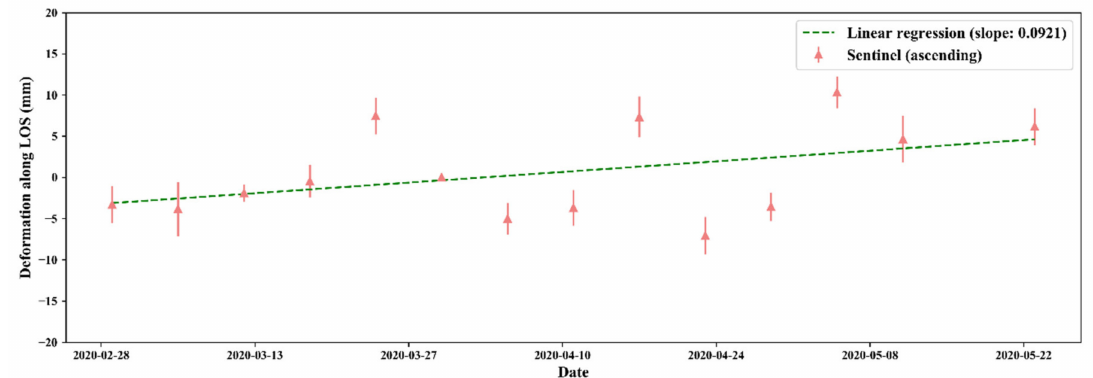
Figure 9. The time series showing the average values of the PS pixels in a 50 m radius of the corner reflector from 27 February 2020 to 4 June 2020 of the ascending orbital geometry. The surface displacement velocity detected by the corner reflector is approximately 39 mm/yr, which indicates short period seasonal fluctuations and is higher than the long period gravity-induced deformation. The orange triangles indicate the average of the selected PS pixels with an error bar of one standard deviation. The green dashed line indicates the linear regression of the time